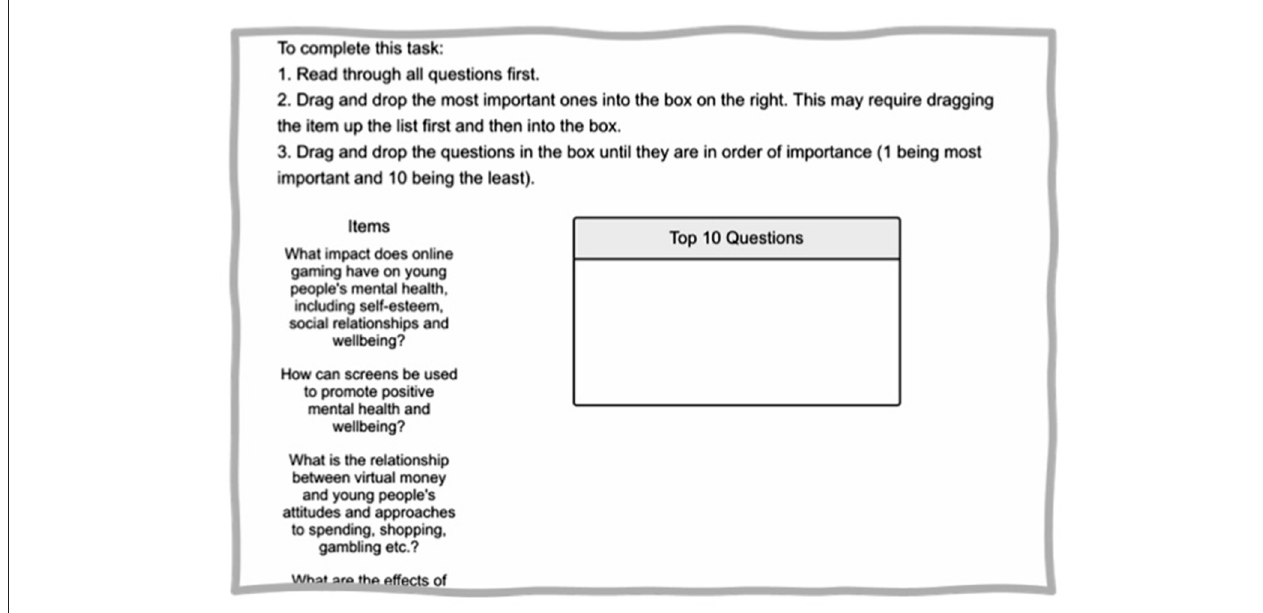
FIGURE 2 | Ranking survey